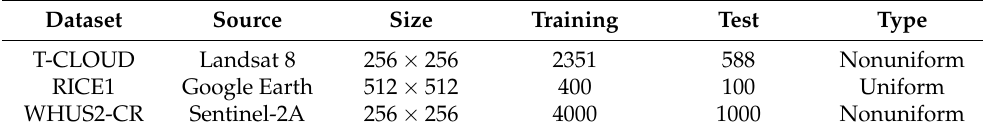
Table 1. Properties of the T-CLOUD, RICE1, and WHUS2-CR datasets used in the experiments. Dataset Source Size Type